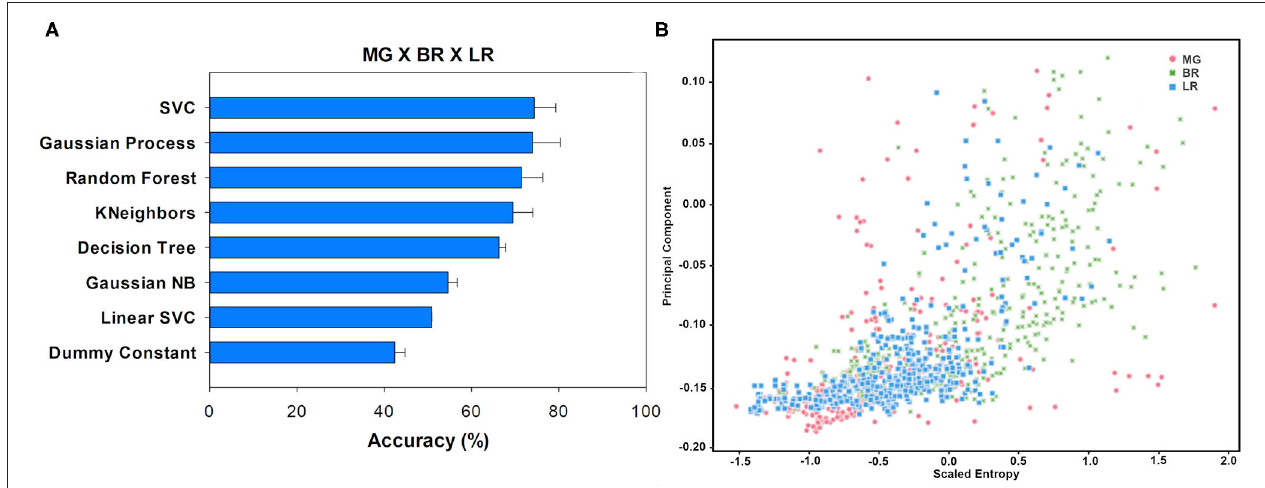
FIGURE 6 | Accuracy (%) and standard deviation (A) of the Machine Learning models used to classify Mature Green (MG), Breaker (BR), and Light Red (LR) classes. Scatter plot (B) showing PCA1 and Scaled Entropy distribution (Mature Green × Breaker × Light Red). Red dots: MG; green dots: BR; blue dots: LR. On the y -axis is the data from PCA1. On the x -axis is the distribution of the Scaled Entropy.